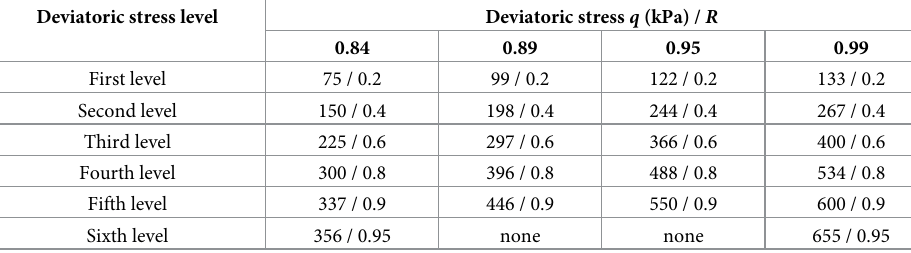
Table 2. Stress loading method (under a confining pressure of